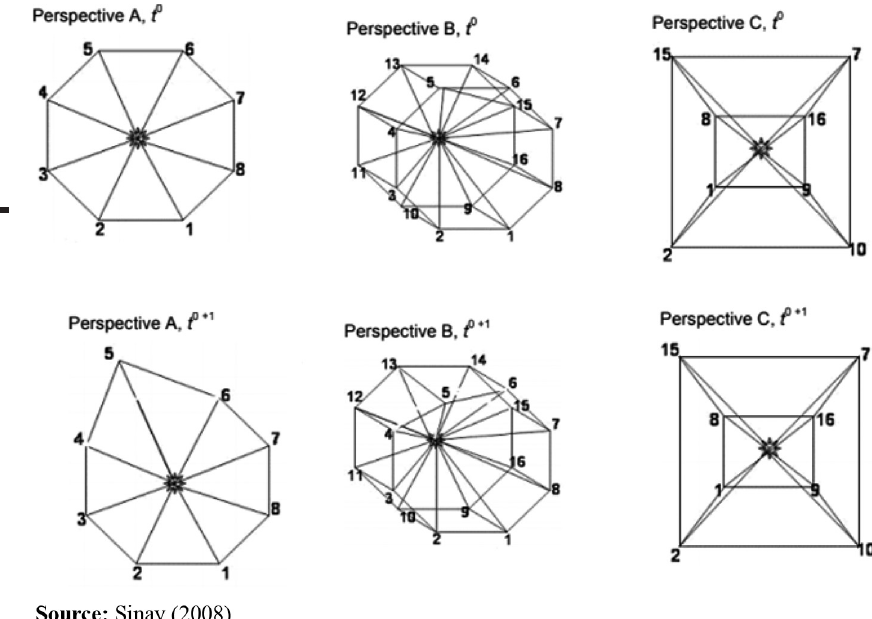
Figure 1. The impact